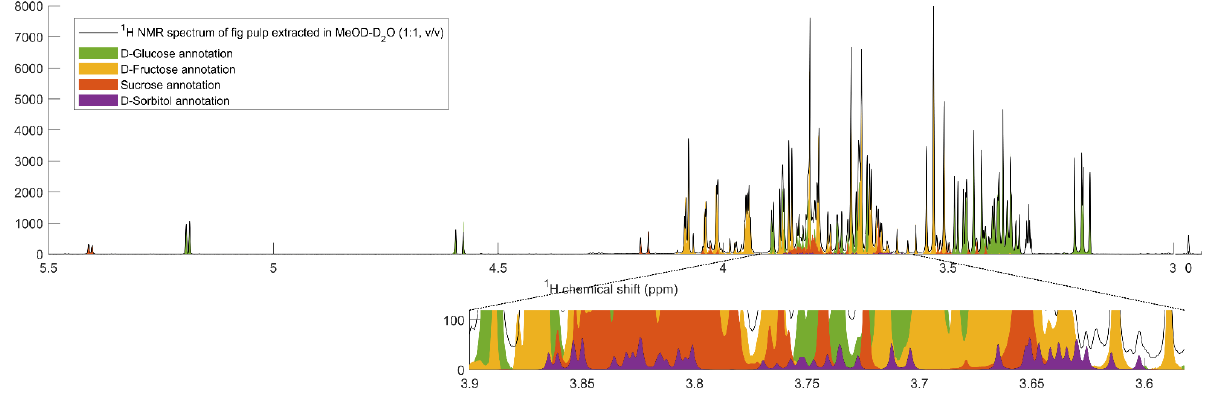
Figure 3. Representative annotated 1 H NMR spectrum of fig pulp extracted in MeOD-D 2 O (1:1, v / v ). Table 1. Concentrations of D-fructose, D-glucose, sucrose and D-sorbitol and their ratios in F. carica cv. Dottato fruits from control and 100 mM NaCl-stressed plants for 48 days. Values are means ± SD of three replicate fruits expressed as mg g − 1 of fruit dry pulp. p ≤ 0.05 is in bold font. The ratio values are expressed as 100 times the real values. Soluble Carbohydrates